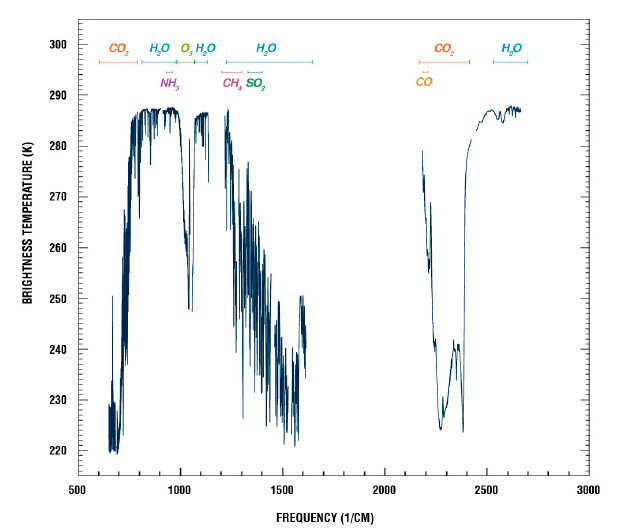
Figure 1. Typical AIRS spectrum and location of key atmospheric constituents. AIRS data are used for weather forecasting, climate process studies and validating climate models (adapted from [1]). For more information, see http://airs.jpl.nasa.gov.